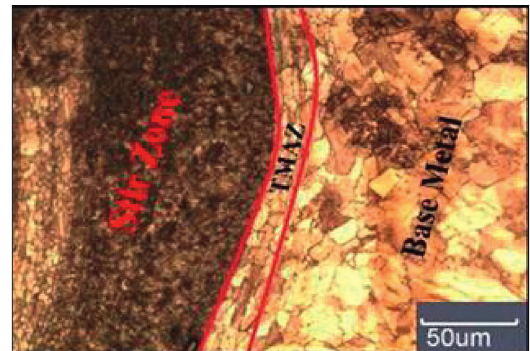
Figure 14: Optical micrograph representing stir zone/TMAZ interface.